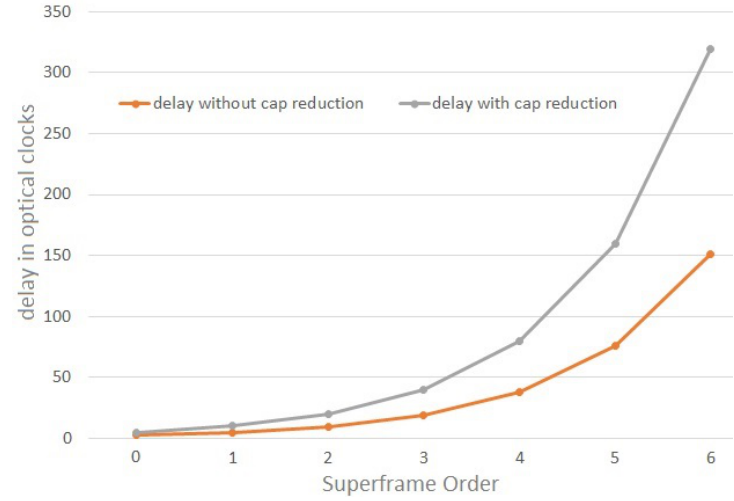
Figure 13. Adverse delay impact of CAP